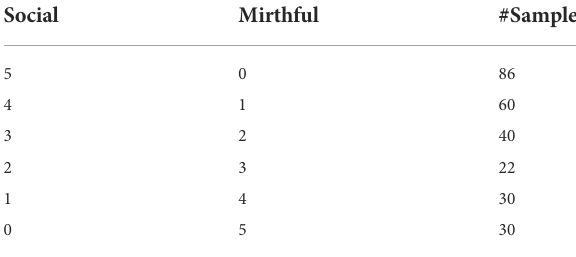
TABLE 1 Distribution of annotated samples on laughter type (Social: number of people who annotated the sample as social; Mirthful: number of people who annotated the sample as